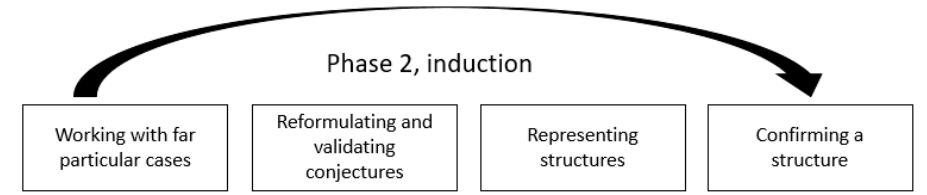
Figure 11. Induction phase.